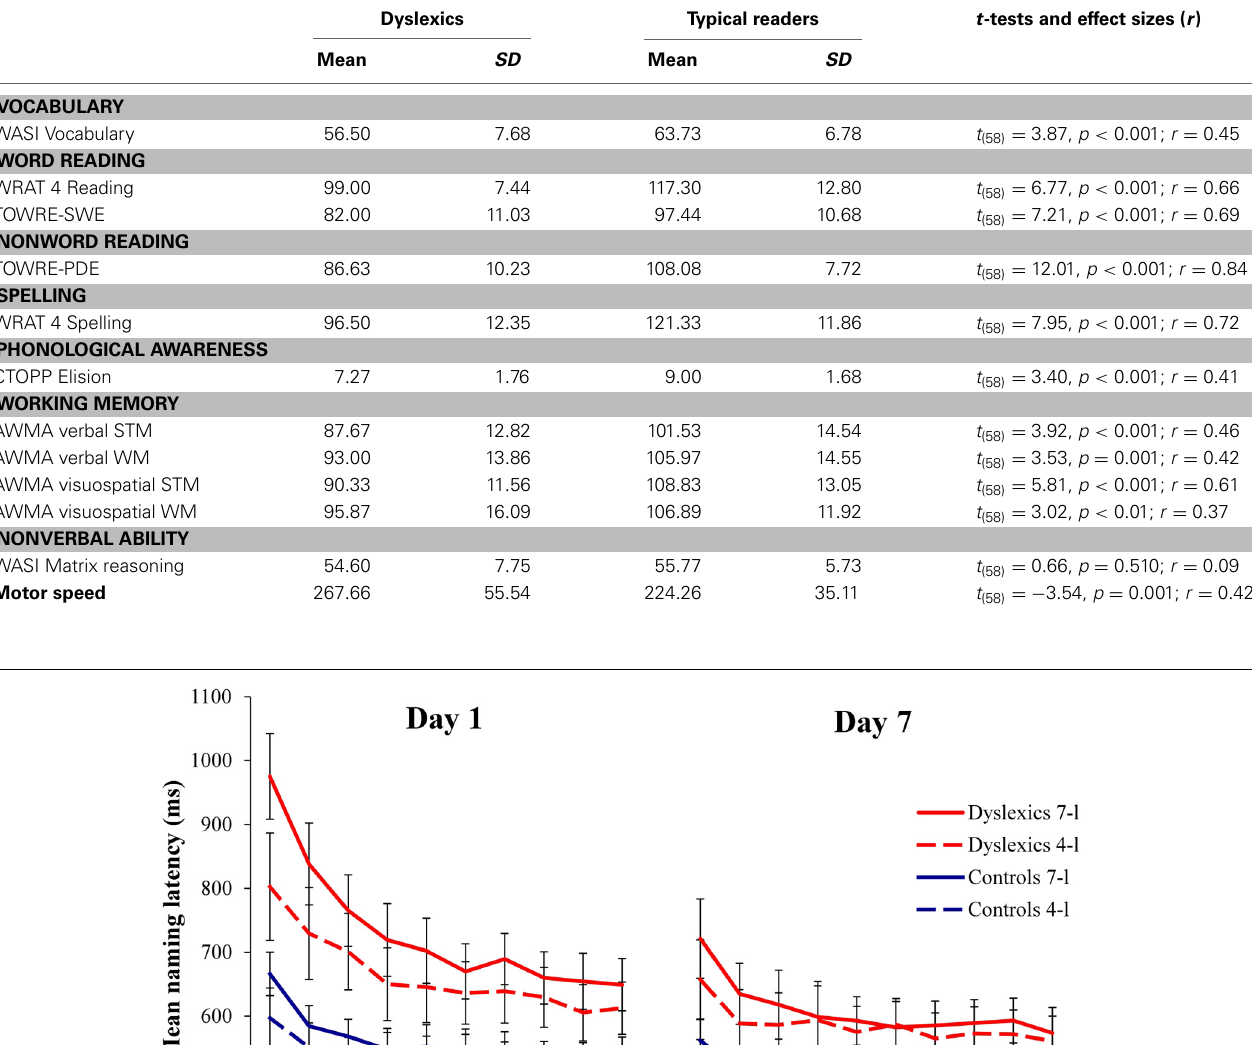
Table 1 | Results of the dyslexic and typical readers on the psychological test battery. Dyslexics Typical readers